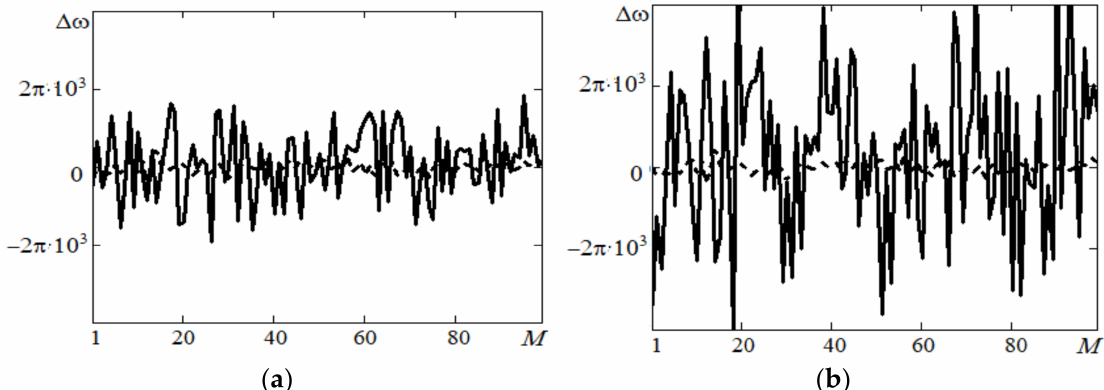
Figure 2. Frequency fluctuations and frequency deviation estimations for a system of oscillators at: ( a ) all N have the same parameters; ( b ) N oscillators are divided into two equal groups with different